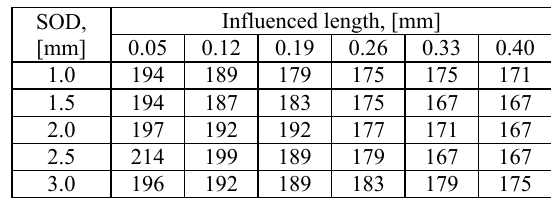
Table 4. HV values for 20mm MTH